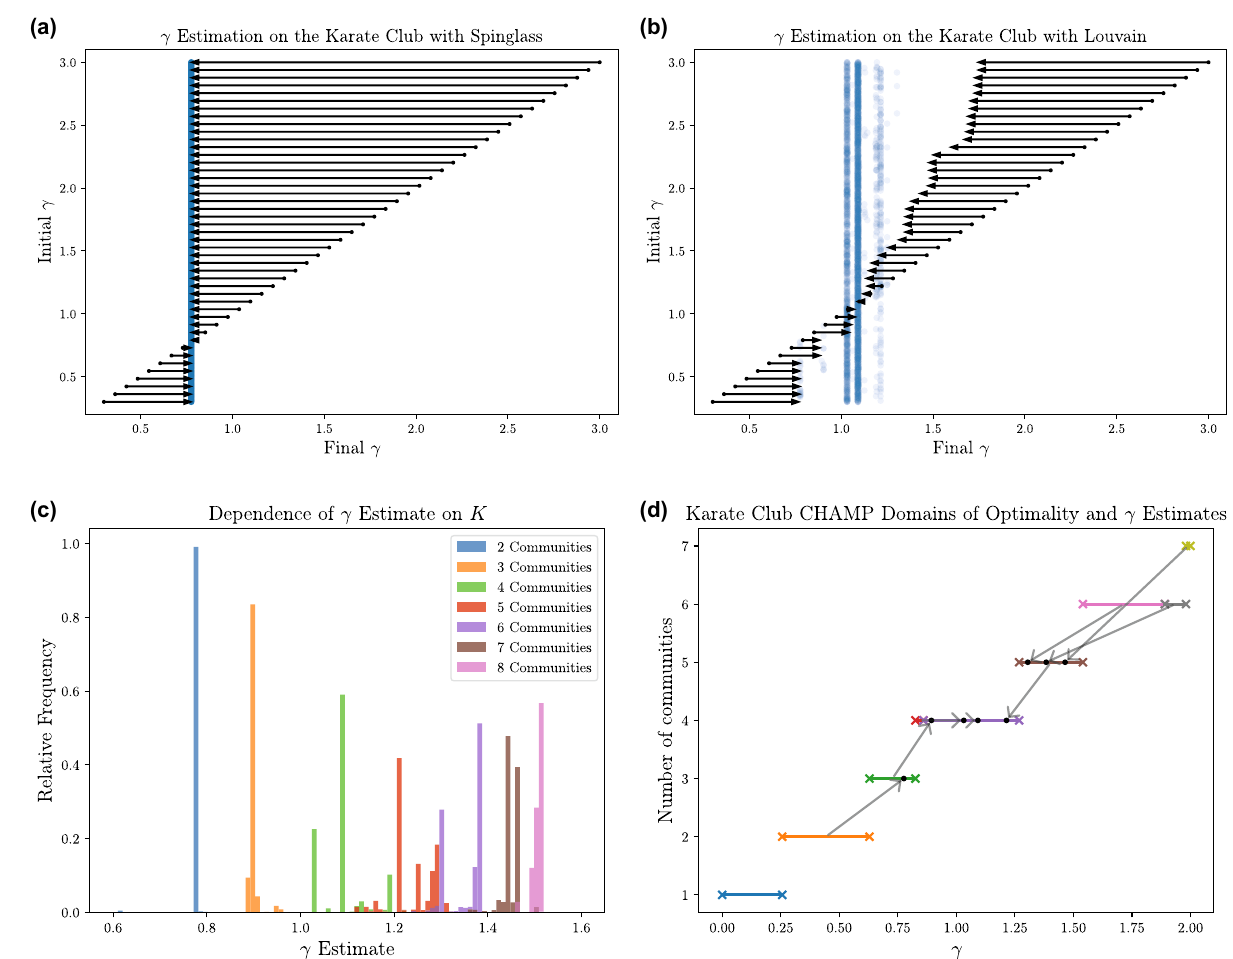
Figure 2. Iterative steps to determine “correct” values for the resolution parameter γ on the Zachary karate club. Behavior observed using individual partitions obtained at each γ by the ( a ) spin glass algorithm 14 as implemented in igraph 24 , restricted to finding K = 2 communities and the ( b ) Louvain algorithm 10 , which does not fix K , as implemented by Traag 25 . Arrows show average movement (over 100 trials) in γ with the base of the tail at the initial γ used and the head of the arrow indicating the (averaged) γ estimate. Blue points indicate paired initial and final γ values obtained after multiple steps (from multiple runs at each γ ). ( c ) Frequencies of γ estimates from 1e7 runs of Louvain on a uniform γ ∈ [ 0, 2 ] grid, relative to observed partitions with the same number of communities K . ( d ) Domains of optimality and associated γ estimates for the 9 partitions of the Zachary karate club admitted by CHAMP starting from the 1e7 Louvain calls on γ ∈ [ 0, 2 ] mentioned above. Each of these 9 partitions is indicated by a horizontal line segment bounded by ‘x’ symbols at height indicating the number of communities. The “correct” value of γ for each of these partitions (except the trivial 1-community partition, which has no such estimate) is indicated by an arrow from the midpoint of the partition to a corresponding dot, possibly within another domain. Notably, only one of these partitions (with K = 4 ) yields a fixed point under the map, with its arrow pointing inside its